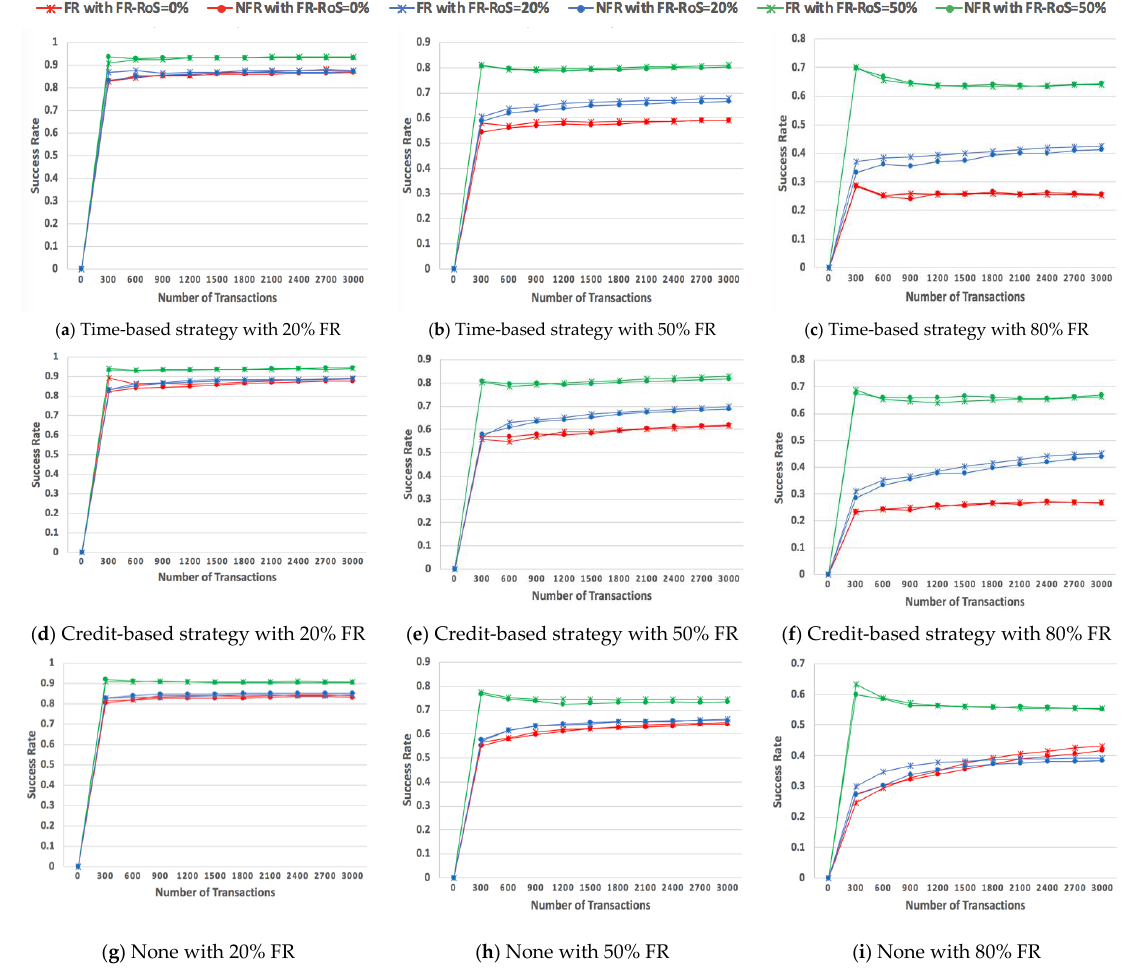
Figure 6. Success rate of each strategy.